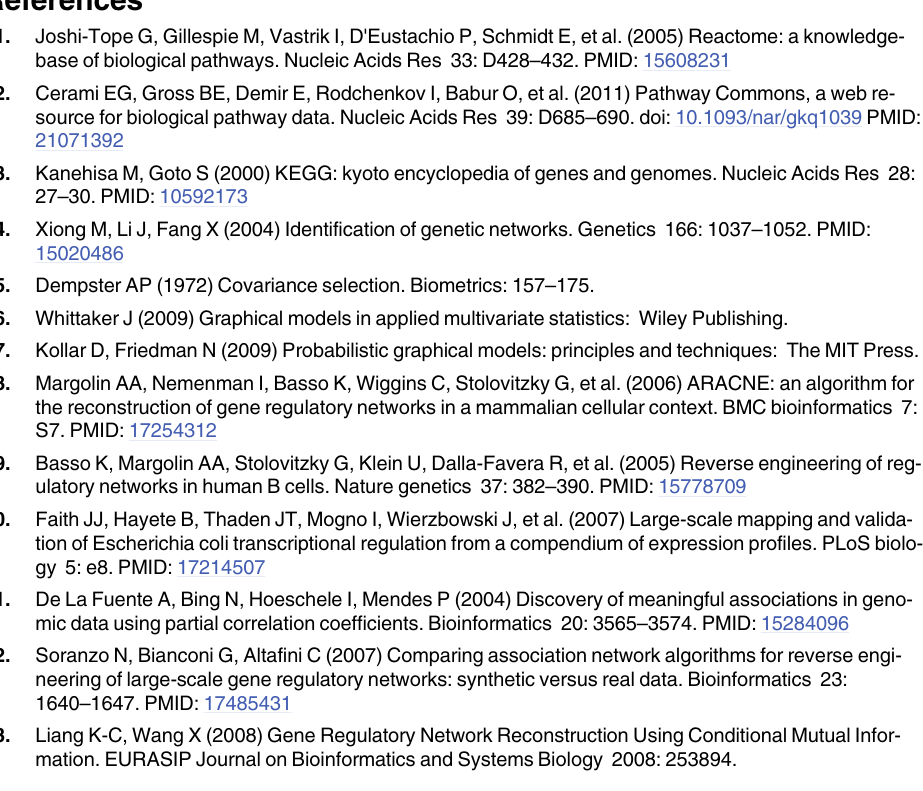
S7 Fig. Sensitivity analysis hESC-cardiomyocyte combinations of genes. The boxplot sum- marize the distribution of scores of contextualized networks when either missing (in green) or wrong (orange) information about combinations randomly selected is given to PRUNET. S1 Table. Prior knowledge networks, Boolean models and Booleanized phenotypes (train- ing set). S2 Table. PRUNET validation results. S3 Table. Simulated perturbation results. S4 Table. Sensitivity analysis